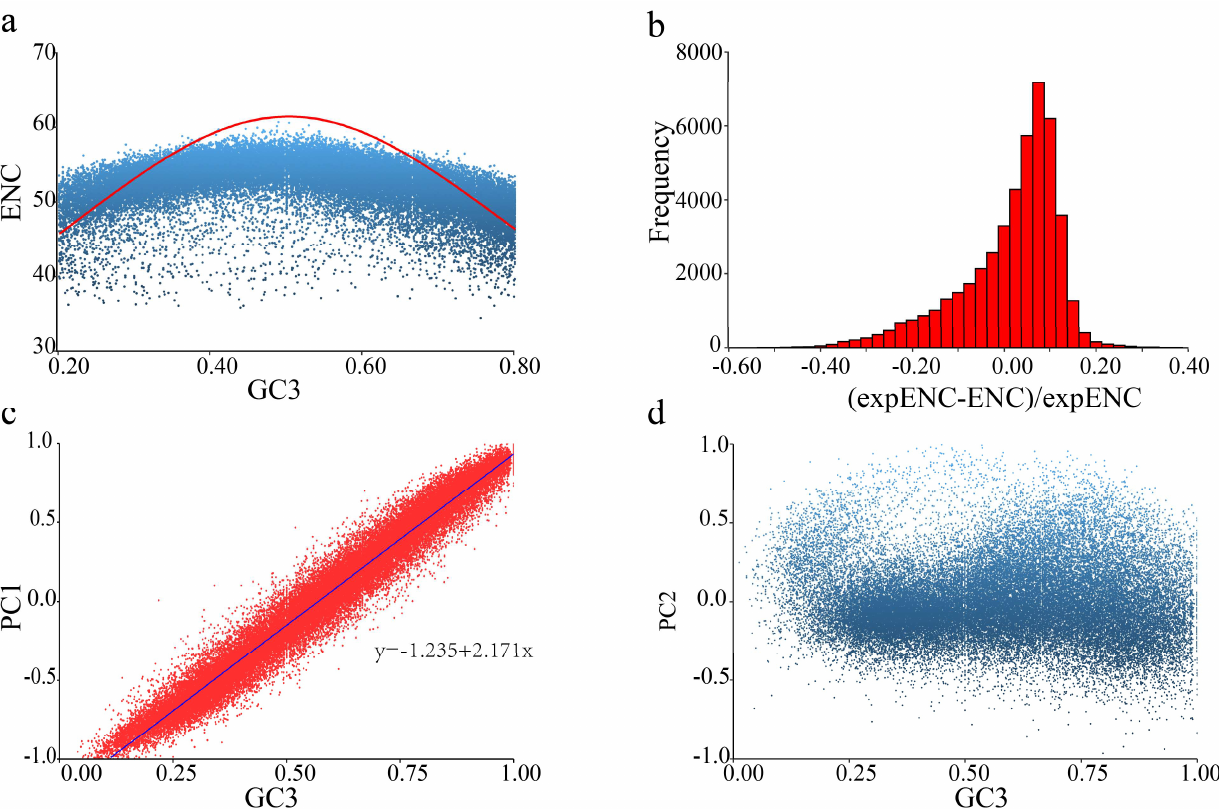
Figure 2. Codon usage bias of CDS. ( a ) The ENC-GC3 plot. GC3 is the GC content at the third codon position, and the solid line represents the expected curve when codon usage bias is only affected by mutation pressure. ( b ) Distribution of deviations from the expected ENC. ( c ) Correlation of PC1 and GC3. ( d ) Correlation of PC2 and GC3. PC1 and PC2 are the first two principal components of the codons’ RSCU matrix.